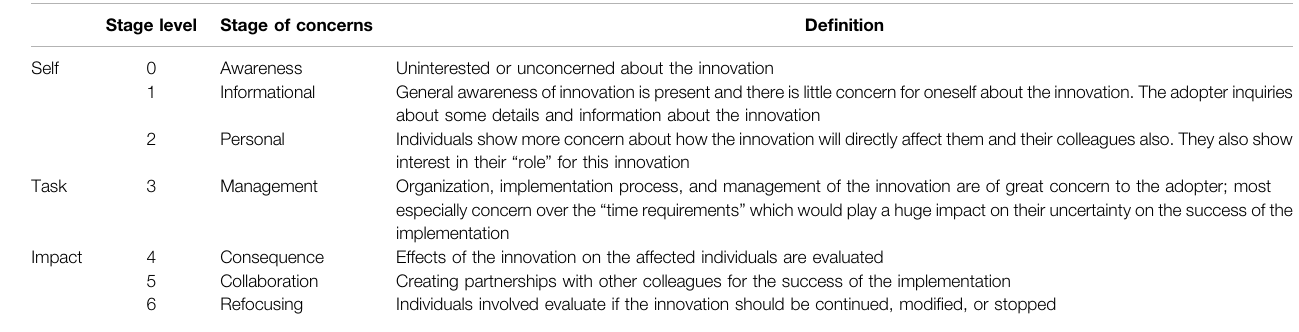
TABLE 2 | CBAM stages of concerns. Stage level Stage of